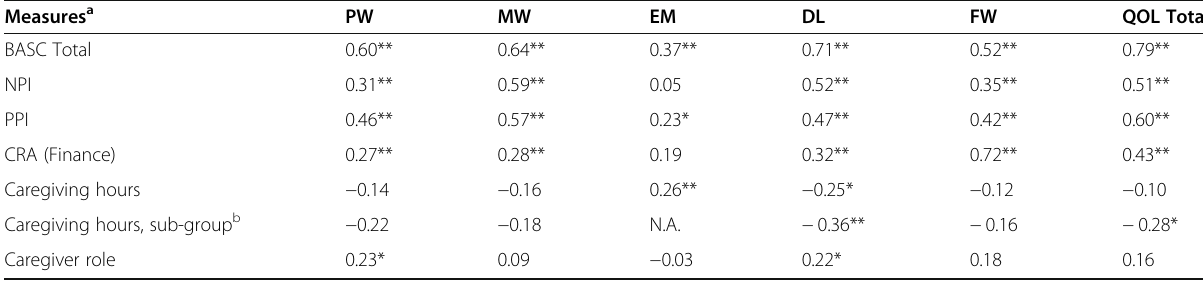
Table 4 Correlation with validity criterion measures Measures